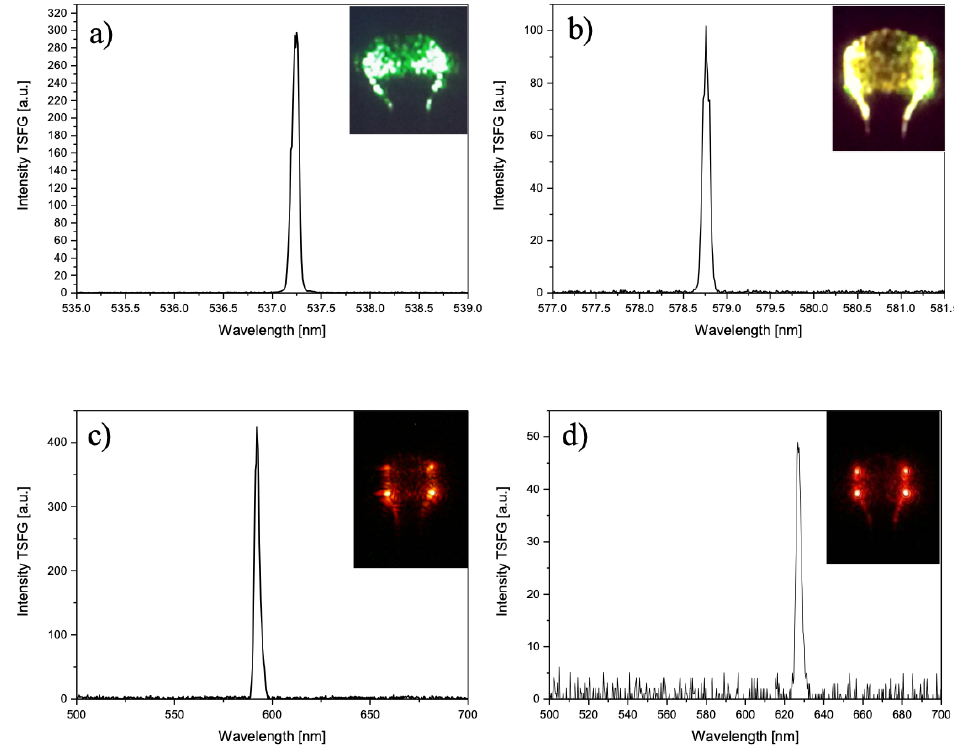
Figure 6. Various spectra obtained with different pump wavelengths showing TSFG standing waves generated among cascaded Raman lines with emission at: ( a ) 537.2 nm; ( b ) 578.8 nm, ( c ) 592 nm, and ( d ) 625 nm. Reproduced with modifications from Ref.